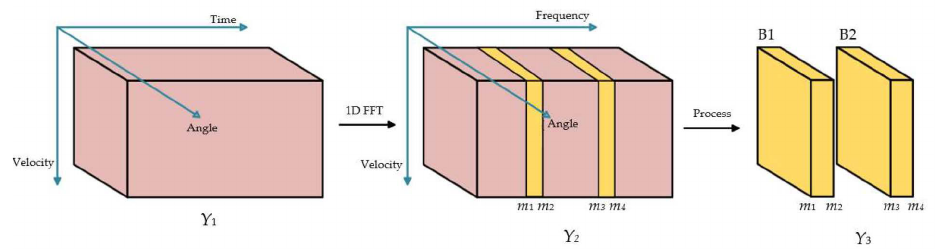
Figure 3. Frequency domain